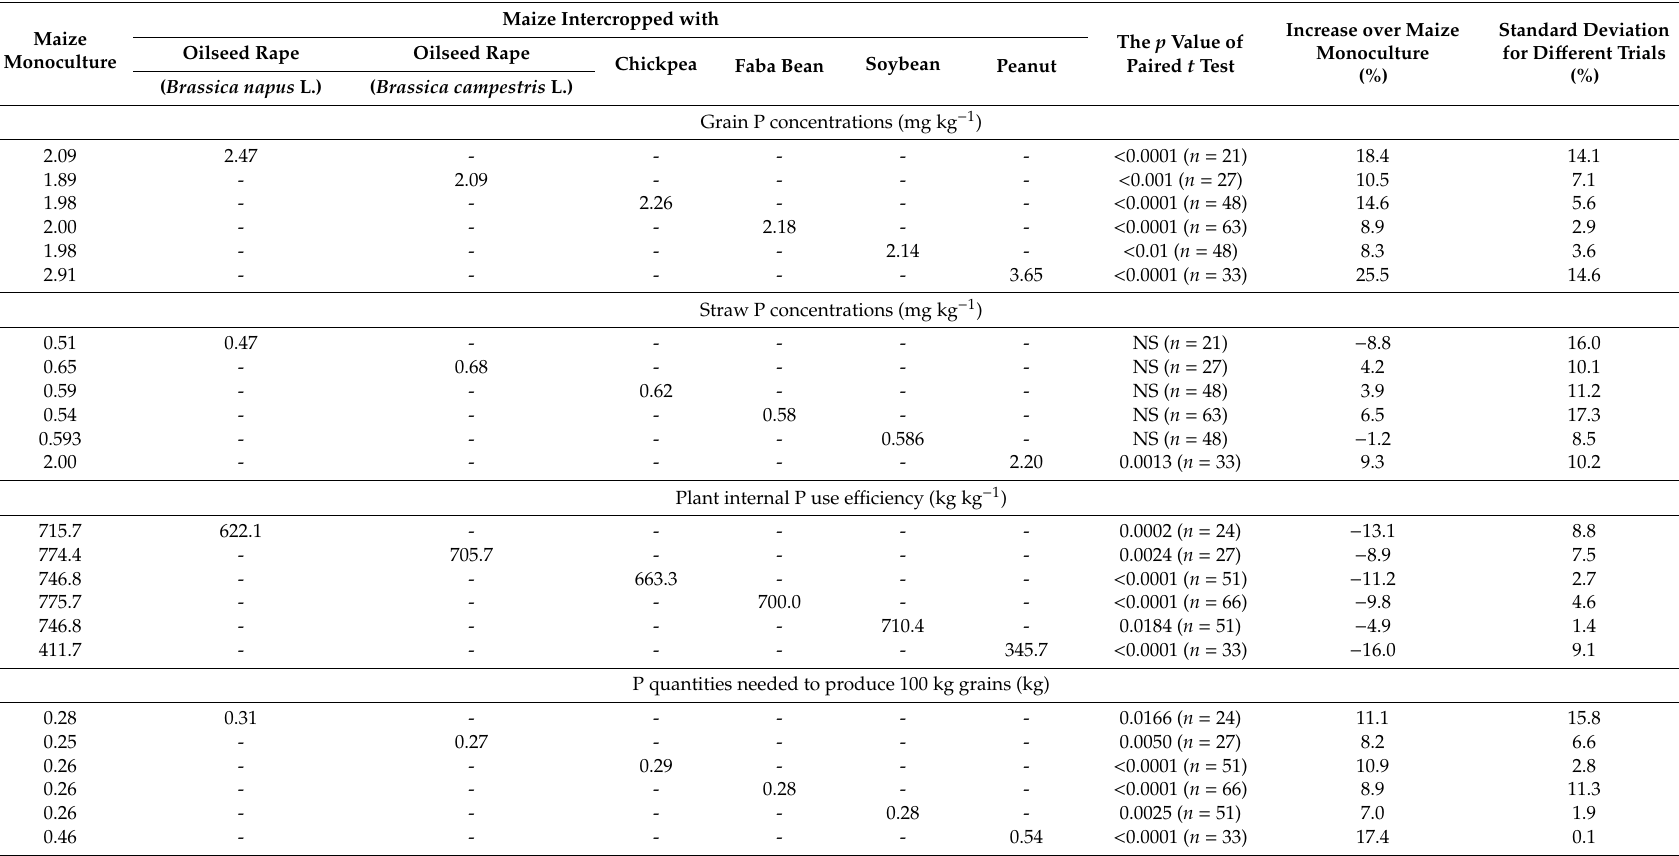
Table 9. Maize grain and straw P concentrations, plant internal P use e ffi ciency, and P quantities needed to produce 100 kg grains as a ff ected by intercropping with legumes or oilseed rape across all experimental sites, study years, and P application